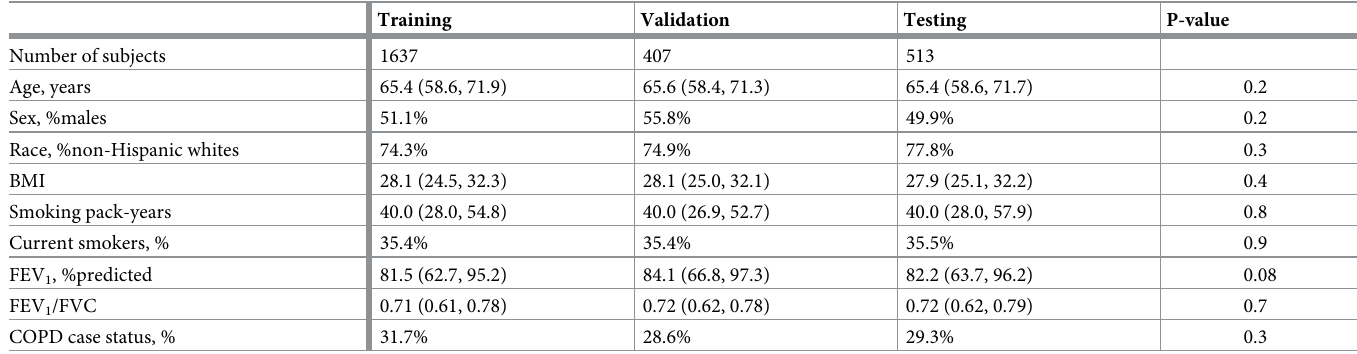
Table 1. Characteristics of subjects.